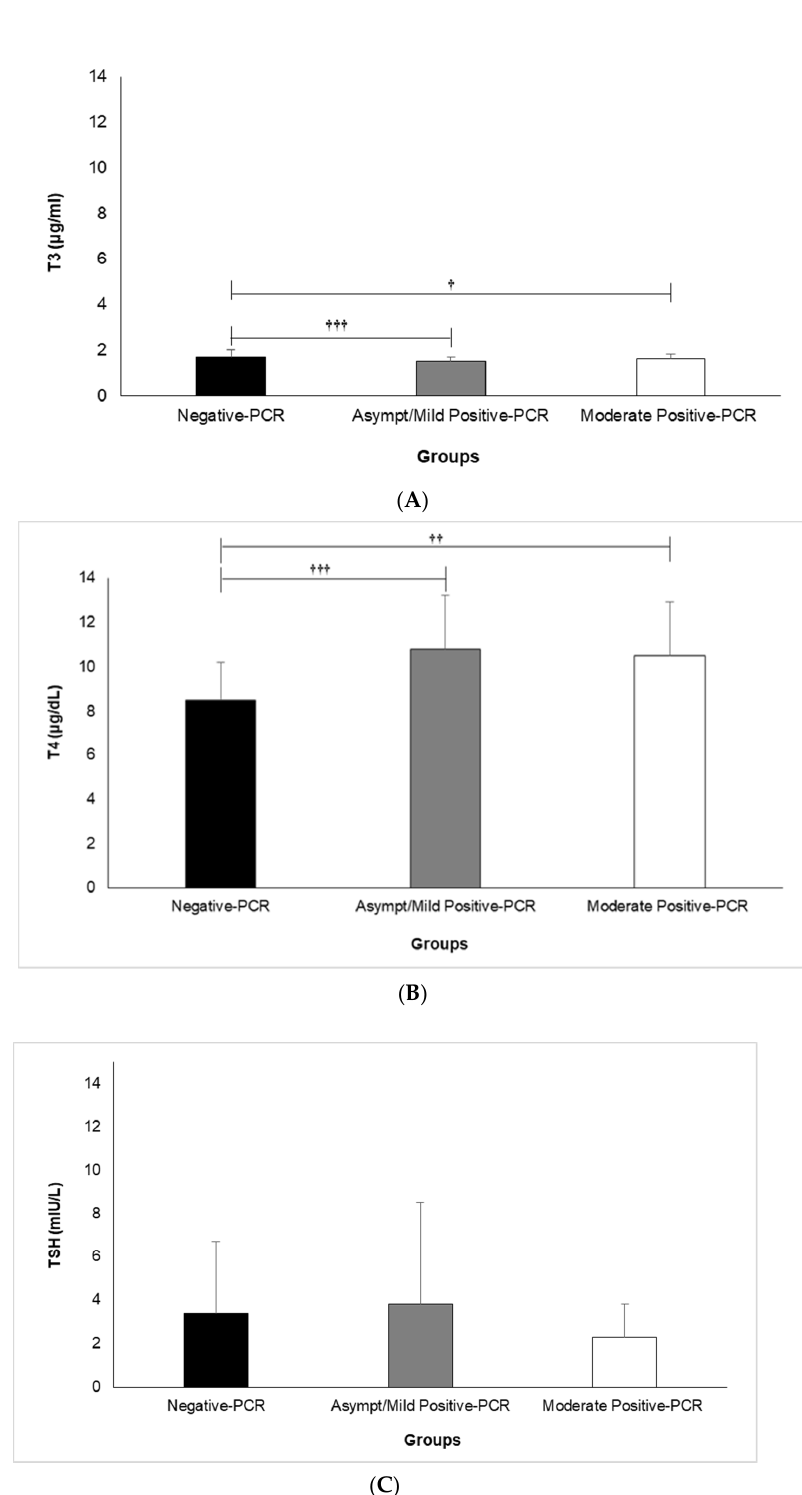
Figure 1. Comparison of Serum Levels of T3 ( A ), T4 ( B ), and TSH ( C ) among different clinical classifications of COVID-19 according to severity. Analysis of variance (ANOVA) was applied to analyze data. T3: triiodothyronine, T4: thyroxine, TSH: thyroid-stimulating hormone. † ( p < 0.05), †† ( p <0.01), and ††† ( p <0.001).